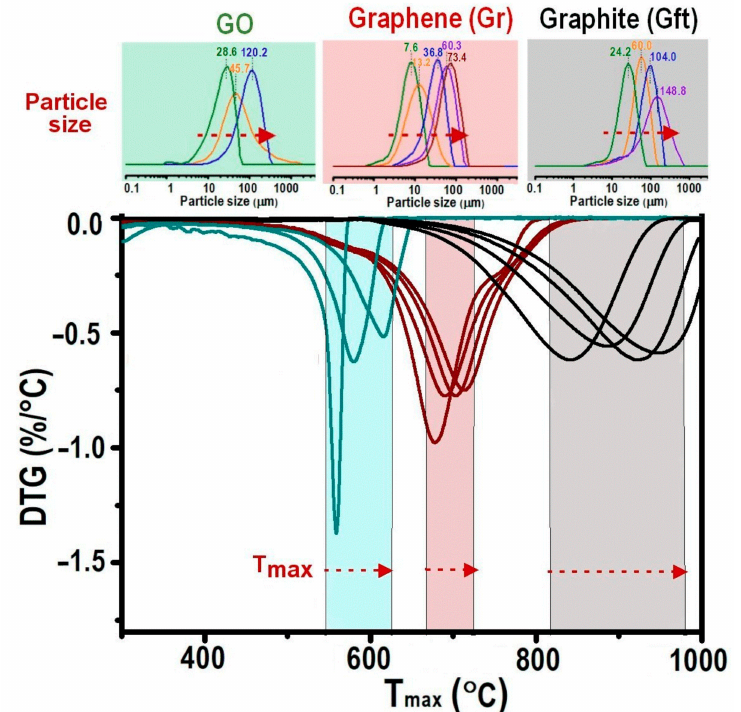
Figure 4. Summary of TGA-DTG graphs for GO, graphene and graphite with different particle size showing non-overlapped T max values and the ability of TGA-DTG method to distinguish GO and graphitic impurities from graphene for their quality